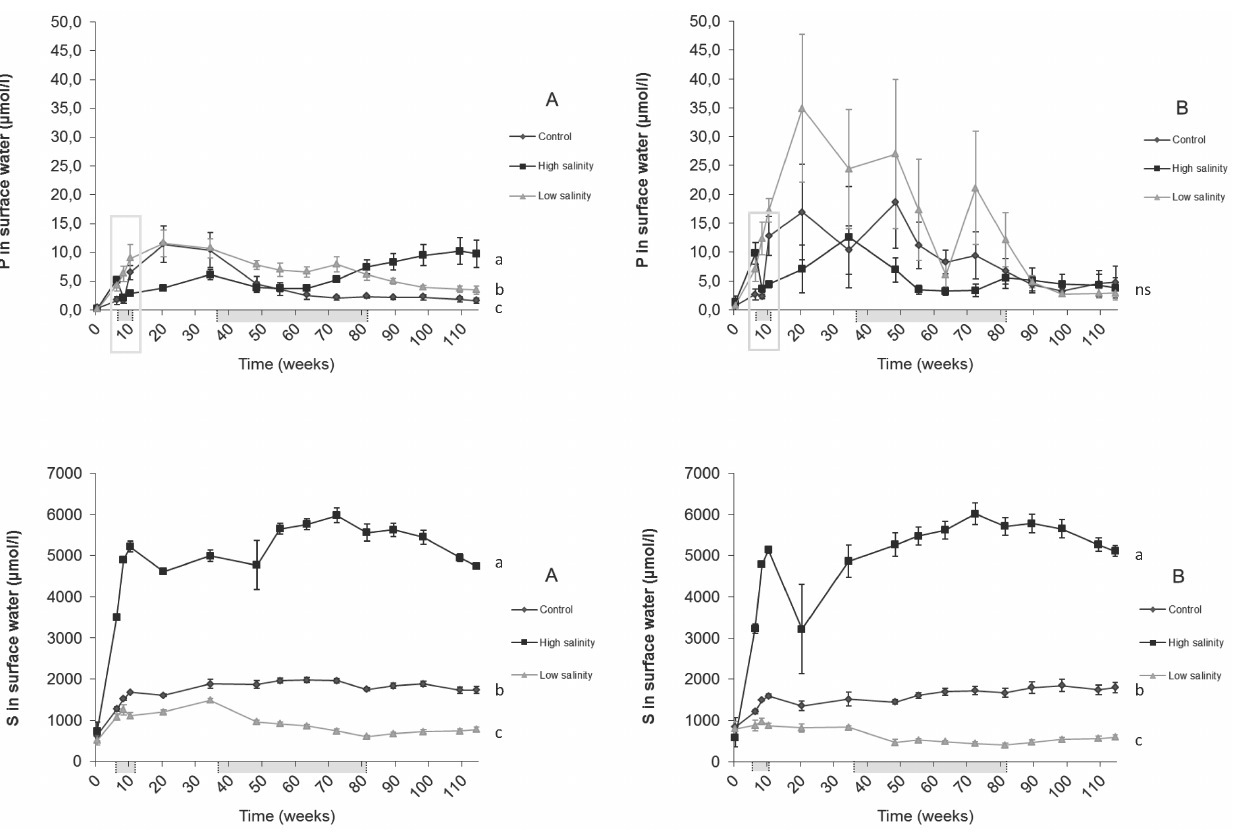
Figure 3. Phosphorus (P) and sulphur (S) concentrations ( m mol L 2 1 ) in the surface water above both sediments (A: left, B: right). Significant differences between treatments are indicated with different letters. Grey shadings under the x-axis indicate periods with through-flow (see Materials and Methods).